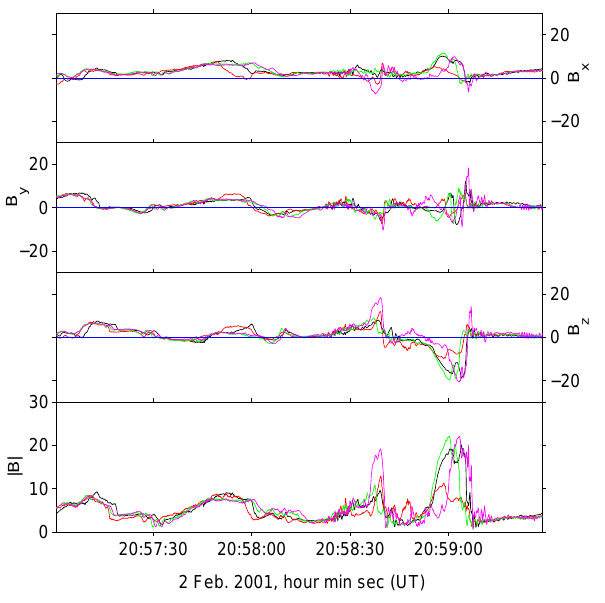
Fig. 9. The variation of the θ Bn angle predicted using the bow shock model normal across the two magnetic field enhancements during interval 2. Panels have the same format as in Fig.